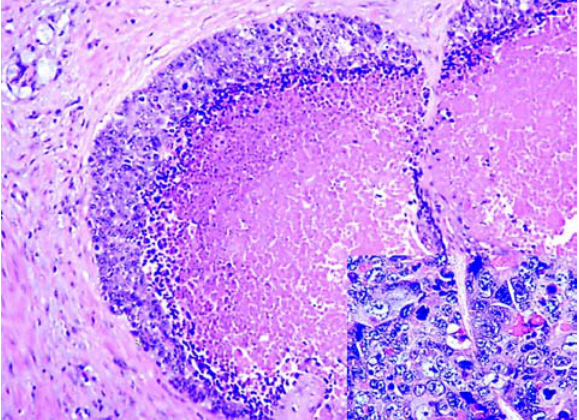
Figure 2 – Abundant “dirty-type” necrosis characteristically seen in colonic-type adenocarcinoma was identified within many malignant glands (HE, X200). Note the small focus of conventional prostatic acinar adenocarcinoma in upper left corner. The tumor cells were columnar to polygonal with high nuclear to cytoplasmic ratios, marked pleomorphism, prominent nucleoli and numerous mitosis (Inset, HE, X400).